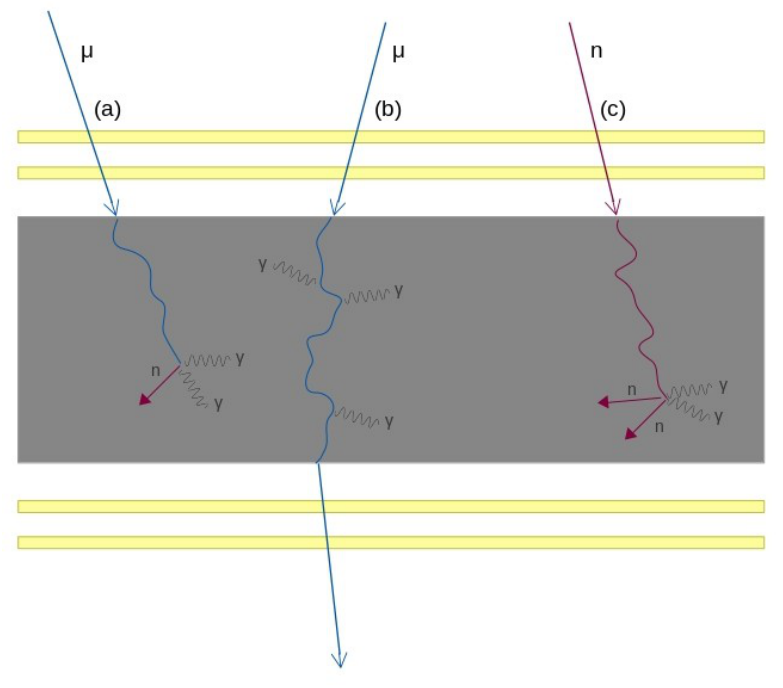
Figure 6. Representation of three processes contribution to secondary particle production: ( a ) negative muon absorption, ( b ) muon bremsstrahlung and ( c ) neutron inelastic scattering and radiative